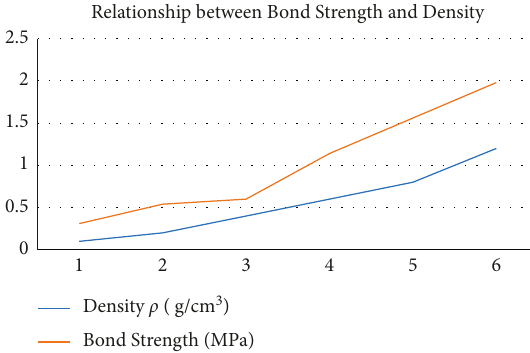
Figure 7: Relationship between bond strength and density. Table 4: Relationship between the bond strength and density. Density ρ /(g/cm3)